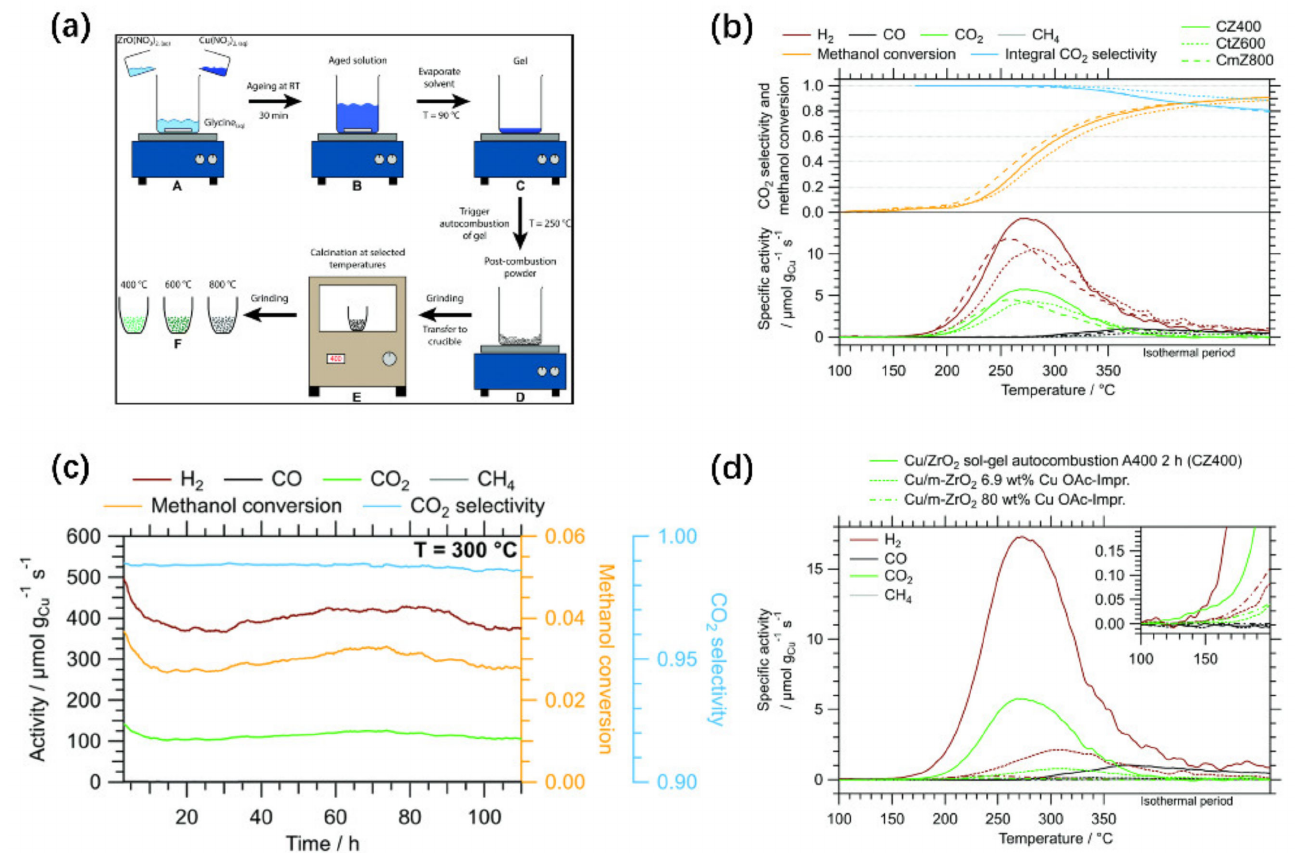
Figure 3. Sol-gel spontaneous combustion synthesis of Cu/ZrO 2 catalyst for methanol steam reform- ing: ( a ) Schematic diagram of sol-gel spontaneous combustion of three samples; ( b ) methanol steam reforming curves of three samples between 100 ◦ C and 350 ◦ C; ( c ) isothermal long-term methanol steam reforming testing of sample Cu/ZrO 2 at 300 ◦ C; and ( d ) comparison of Cu/ZrO 2 with other catalysts. Reproduced with permission [84]. Copyright Royal Society of Chemistry,